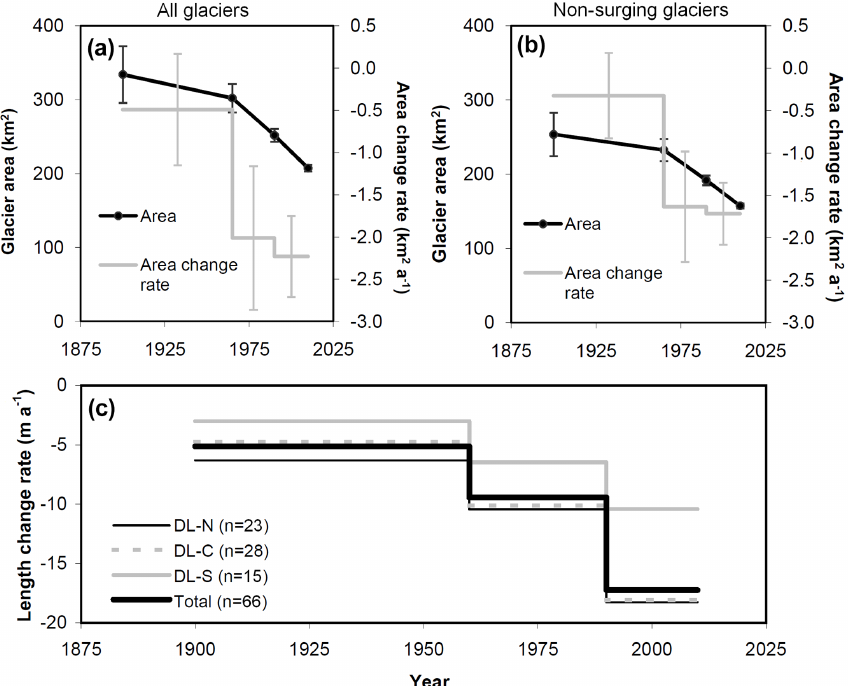
Figure 4. (a) Changes of the total glacier area in Dickson Land. (b) Same as (a) but for non-surging glaciers only. (c) Average glacier length change rates in Dickson Land and its